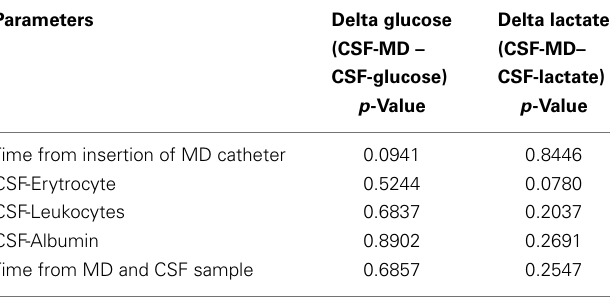
Table 4 | Influence of different parameters on the difference ( ∆ , delta) between glucose and lactate in CSF-MD and CSF, respectively